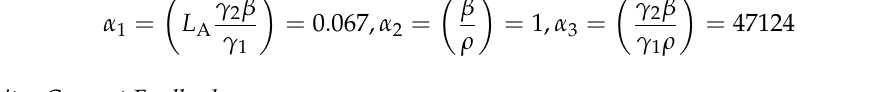
Table 1. Parameters of GaN class-D amplifier with fourth-order